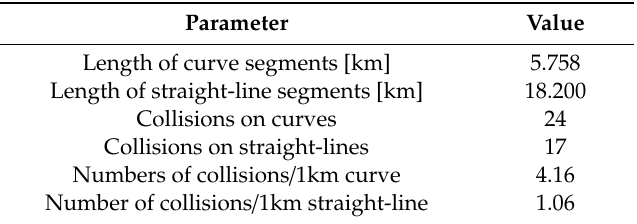
Table 2. Safety characteristics of the analyzed road